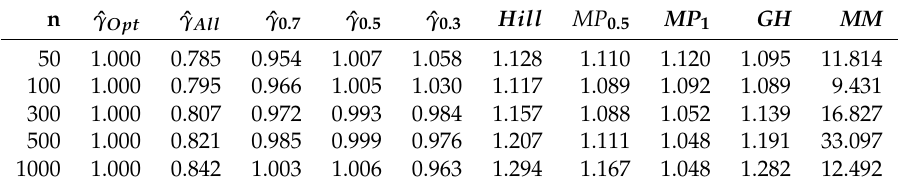
Table 8. Relative RMSE of the estimators for the Stable(1.1) distribution; 1000 Montecarlo